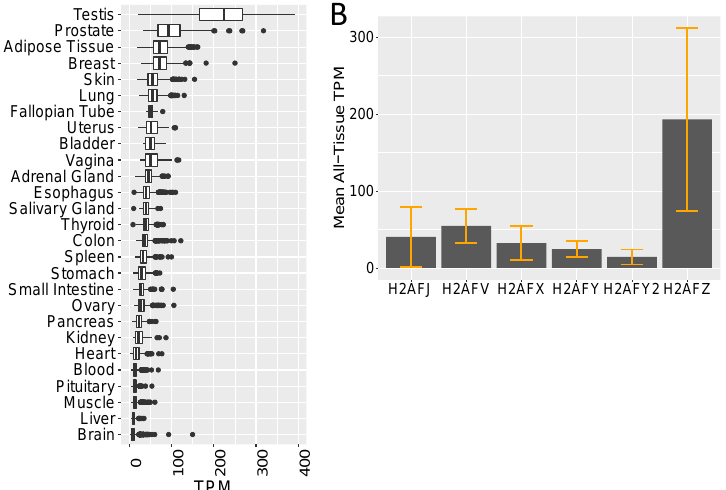
Figure 2. Tissue-specific expression of H2AFJ RNA. ( A ) TPM (transcripts per million) data for H2AFJ RNA in 27 different human tissues. ( B ) Mean all-tissue TPM for the indicated H2A histone variant genes.